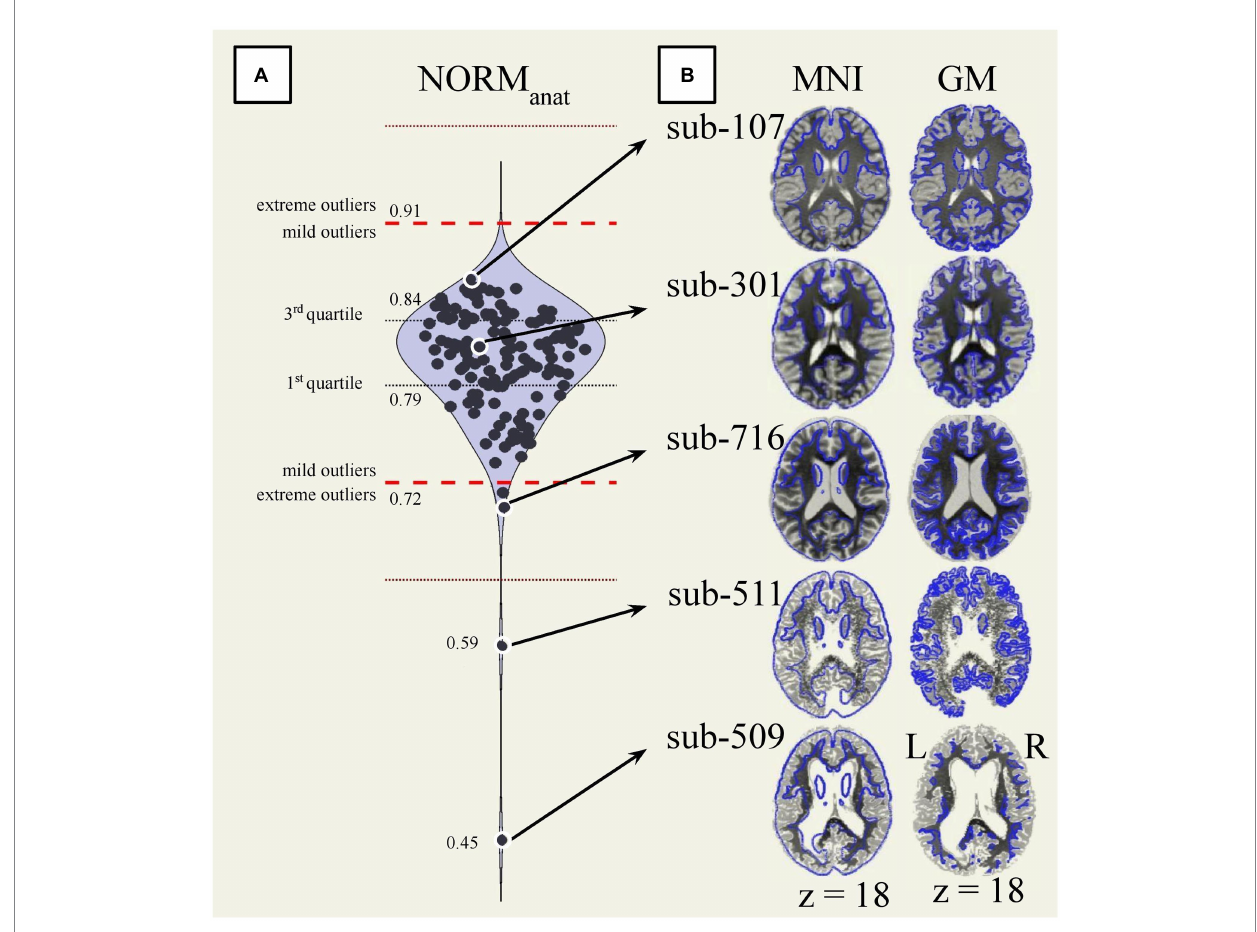
FIGURE 7 Automated and visual quality control of normalized anatomical data. (A) Distribution of the overlap between the normalized anatomical data ( n = 139) and the MNI-space (NORM anat ). Extreme outliers are identified as values 3 IQR above the 3rd quartile or below the 1st quartile (red dotted lines). Mild outliers are values 1.5 IQR above the 3rd quartile or below the 1st quartile (red dashed lines). (B) The same reference axial slice (MNI z = 18) renders the normalized anatomical images from five participants. The participants’ anatomical image is, on the left, overlaid on the 25% boundaries of the gray matter a priori probability maps MNI-space template (blue outline), and on the right, against each participant’s anatomical gray matter boundaries. The participants reported in the figure are ordered from top to bottom based on their NORM anat values. Specifically, compared to the full dataset, sub-107 (S7) had the highest value, sub-301 (S41) was close to the median value, sub-716 (S135) was close to the low mild outlier threshold, sub-511 (S90) and sub-509 (S88) were the two lowest values and extreme outliers. GM, gray matter; MNI, Montreal Neurological Institute space; NORM anat , overlap between the MNI-space and the normalized anatomical